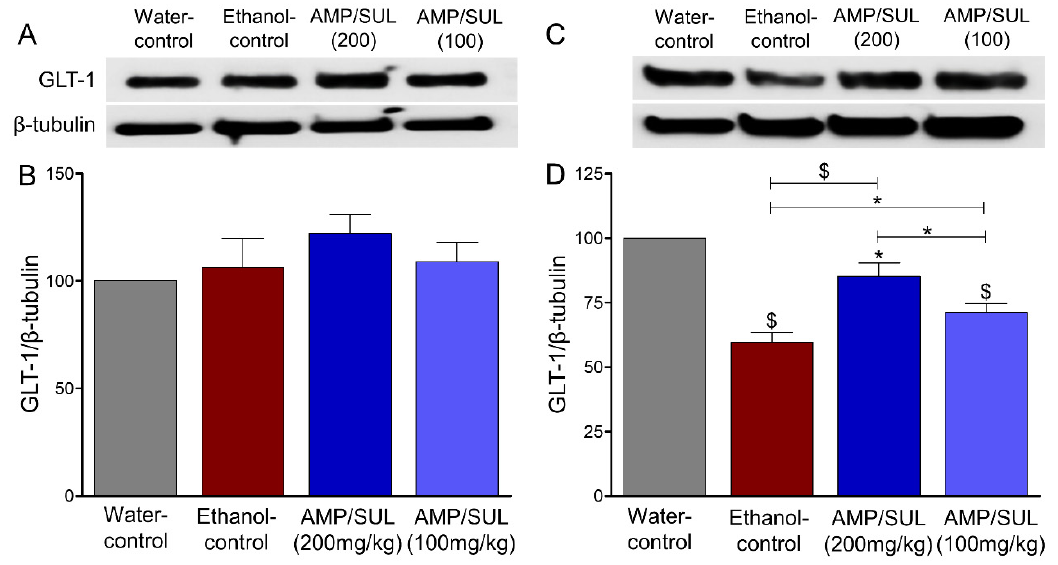
Figure 2. E ff ects of AMP / SUL treatments (100 mg / kg and 200 mg / kg, i.p.) for five days on the expression of GLT-1 in the AcbCo and AcbSh. ( A ) Immunoblot of GLT-1 and β -tubulin in the AcbCo. ( B ) Quantitative analysis using one-way ANOVA followed by Newman-Keuls test indicated that there were no significant di ff erences in the expression of GLT-1 among water-control, ethanol-control, ethanol-AMP / SUL (100 mg / kg), and ethanol-AMP / SUL (200 mg / kg) in the AcbCo. ( C ) Immunoblot of GLT-1 and β -tubulin in the AcbSh. ( D ) Quantitative analysis using one-way ANOVA followed by Newman-Keuls test indicated that there was a significant decrease in GLT-1 expression in the ethanol control group compared to water-control group, while post-treatments with AMP / SUL (100 and 200 mg / kg) upregulated GLT-1 expression compared to ethanol-control group in the AcbSh. Ethanol-AMP / SUL (100 and 200 mg / kg) groups had lower GLT-1 expression compared to water-control group. The symbol of statistical significance between any group and water-control group is shown on the bar of the group. Water-control group data were represented as 100% (relative to water-control). The values are expressed as mean ± SEM ( n = 5 / group), (* p < 0.05, ** p < 0.01 and $ p < 0.001).